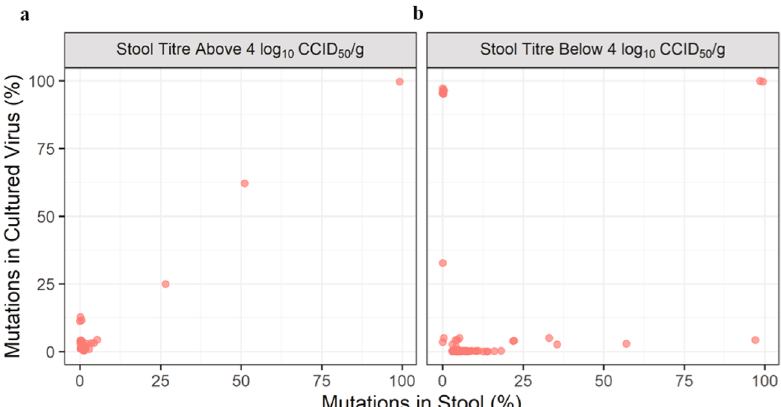
Fig. 2 Comparison of frequency of polymorphisms present in stools and culture-ampli fi ed virus isolates from four participants administered mOPV2. Stools were collected at different times post vaccine administration. a Stool samples with viral titre above 4 log CCID 50 / g versus virus ampli fi ed in cell culture from those stool samples. b Stool samples with titre below 4 log CCID 50 /g versus virus ampli fi ed in cell culture from those